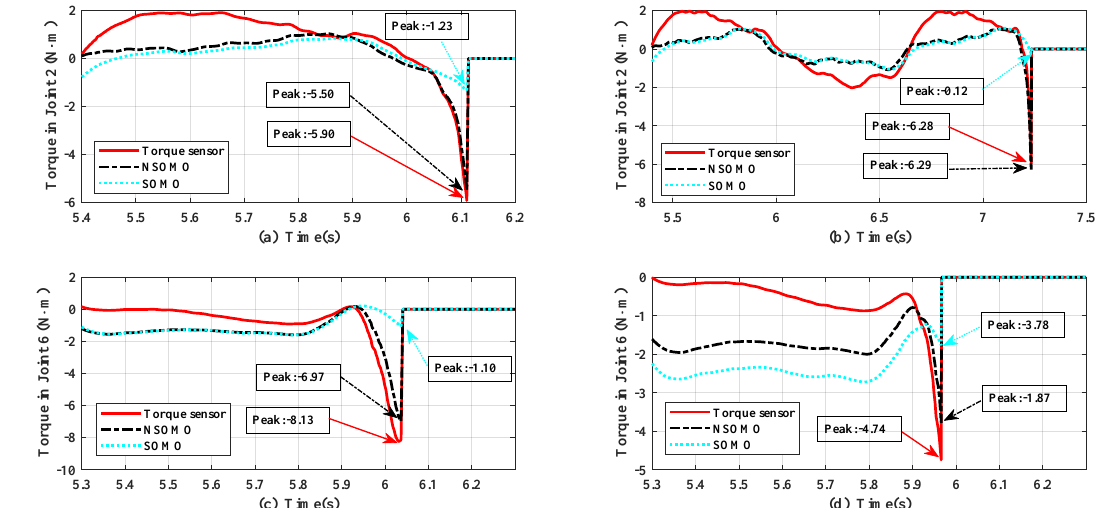
Figure 17. The estimated impact torque. ( a ) Upper arm. ( b ) Lower arm. ( c ) Back. ( d )